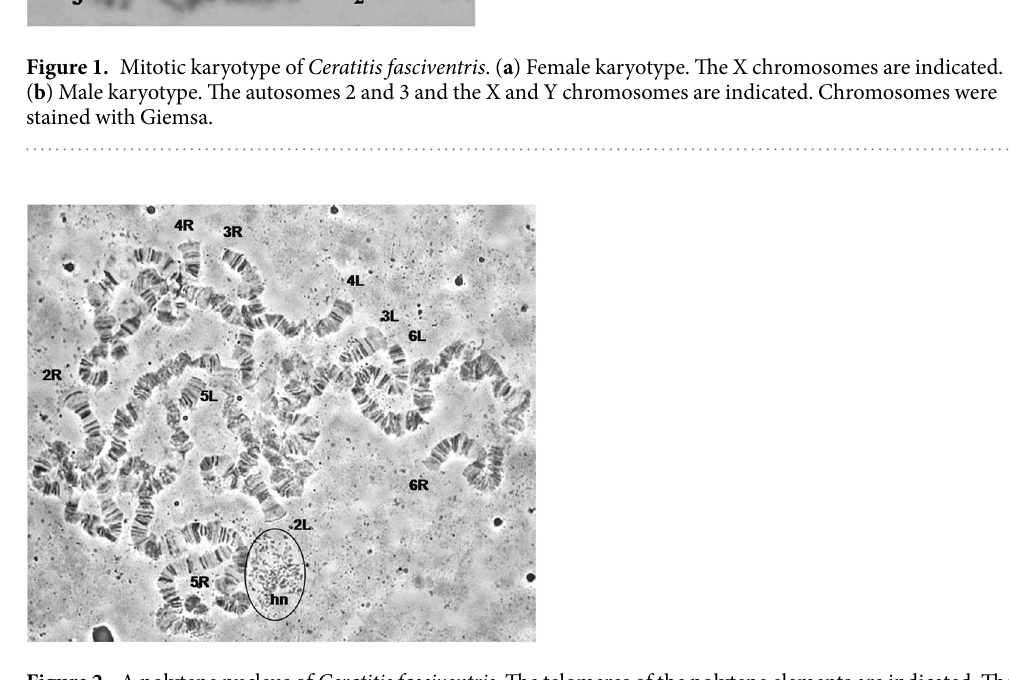
(Fig. 1b). The sex chromosomes are identified as the heteromorphic pair (XY) of heavily stained chromosomes in the mitotic complement (Fig. 1b). This karyotype is consistent with the karyotype of most Tephritidae species analyzed so far 59–61, 65, 67, 68, 70, 71, 73–77, 79, 111 .